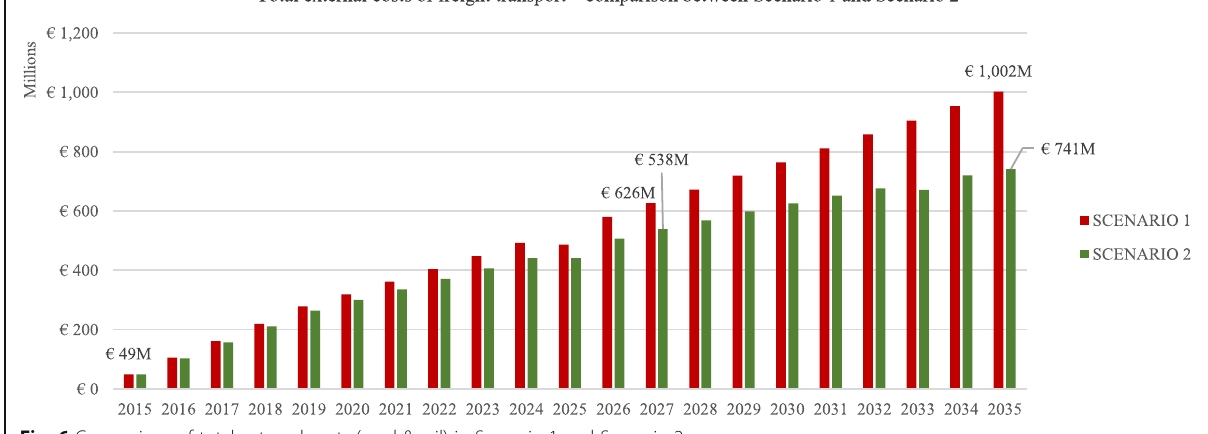
Fig. 6 Comparison of total external costs (road & rail) in Scenario 1 and Scenario